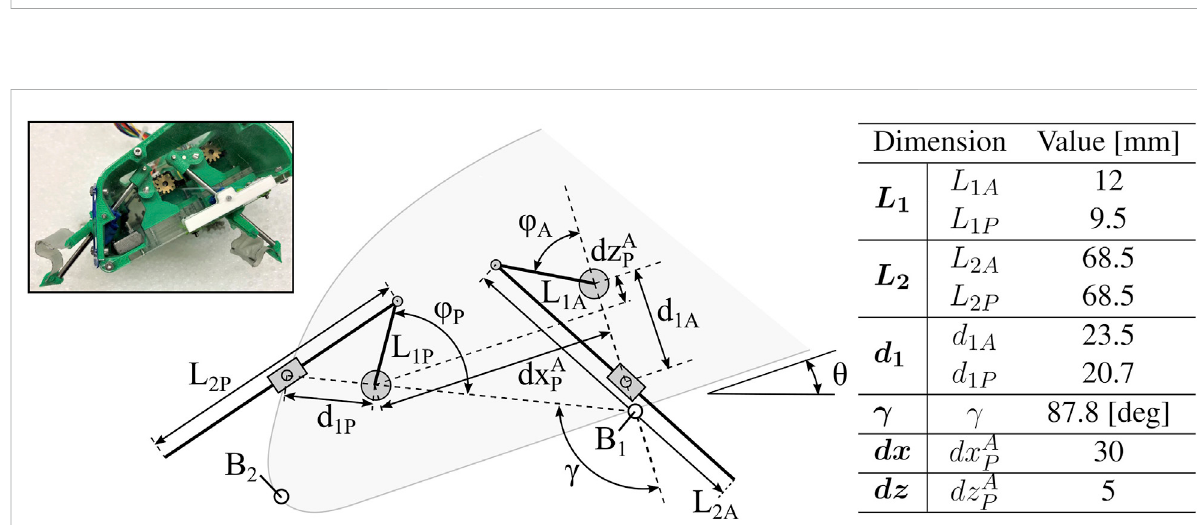
FIGURE 3 Robot Hardware Components. Image of full robot assembly, with subassembly details shown, including the cuticle design, homing hall effect sensors, and retractable fabric leg design.